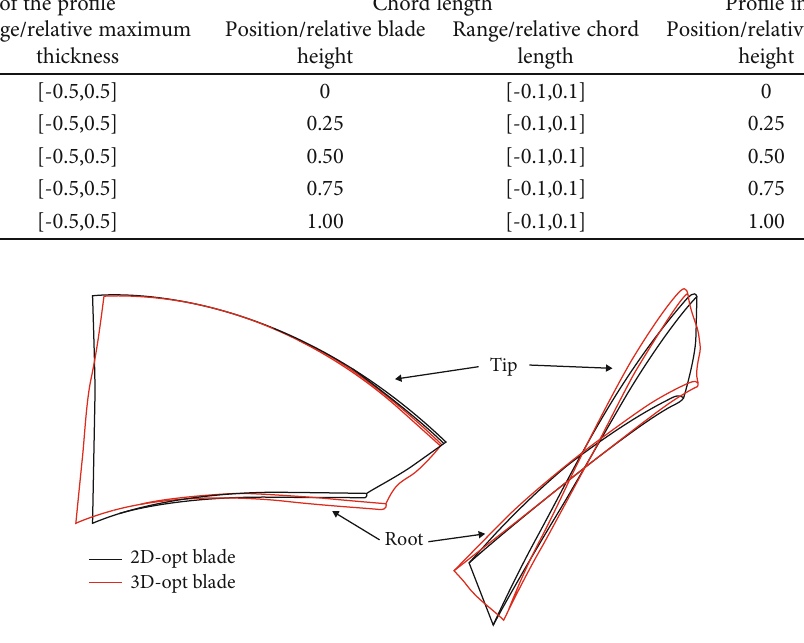
Figure 7: Blade shape before and after the optimization. Table 5: Aerodynamic performance of the three rotors at the design